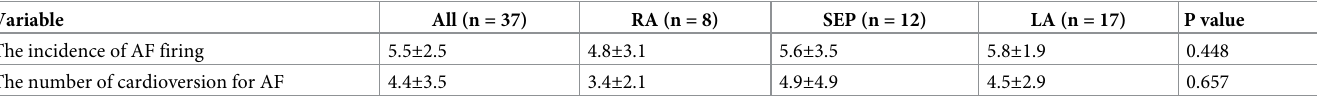
trigger from SEP and LA non-PV trigger (A), and the other is RA-CSd to distinguish SEP non-